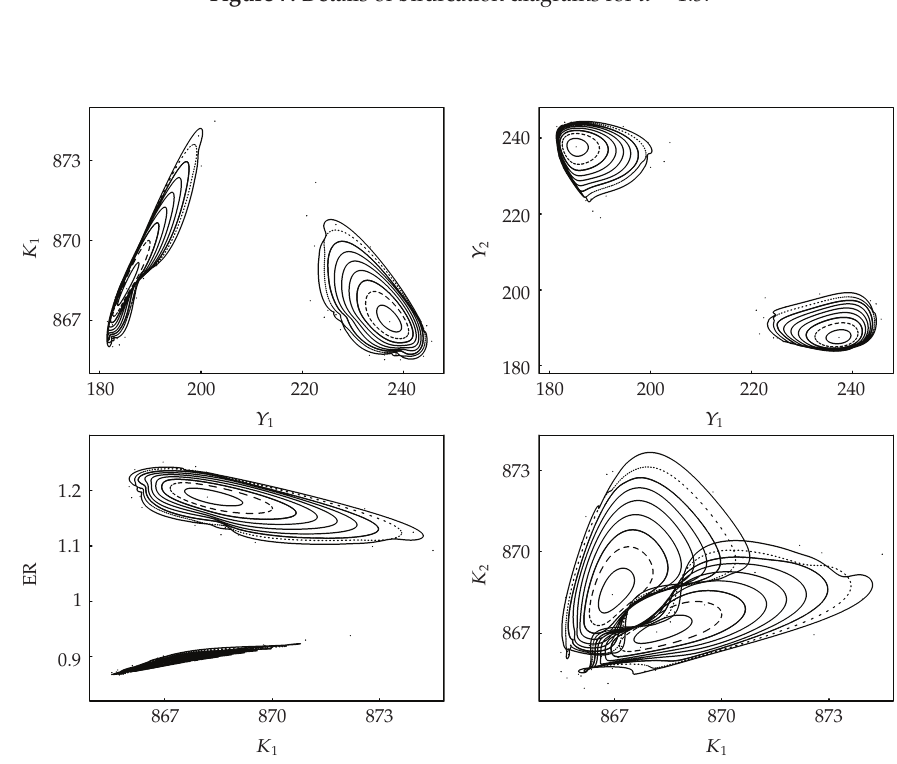
Figure 8: Period-2 cycles for δ (cid:9) 0 . 6, α (cid:9) 2